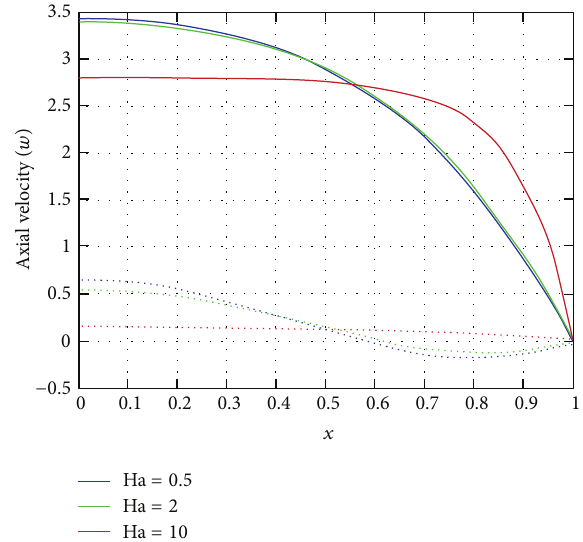
Figure 11: Variation of unsteady axial velocity profile at the peak (solid lines) and minimal (dotted lines) velocity for different Hartmann number Ha, with Re = 100 and 𝛼 = 5 .